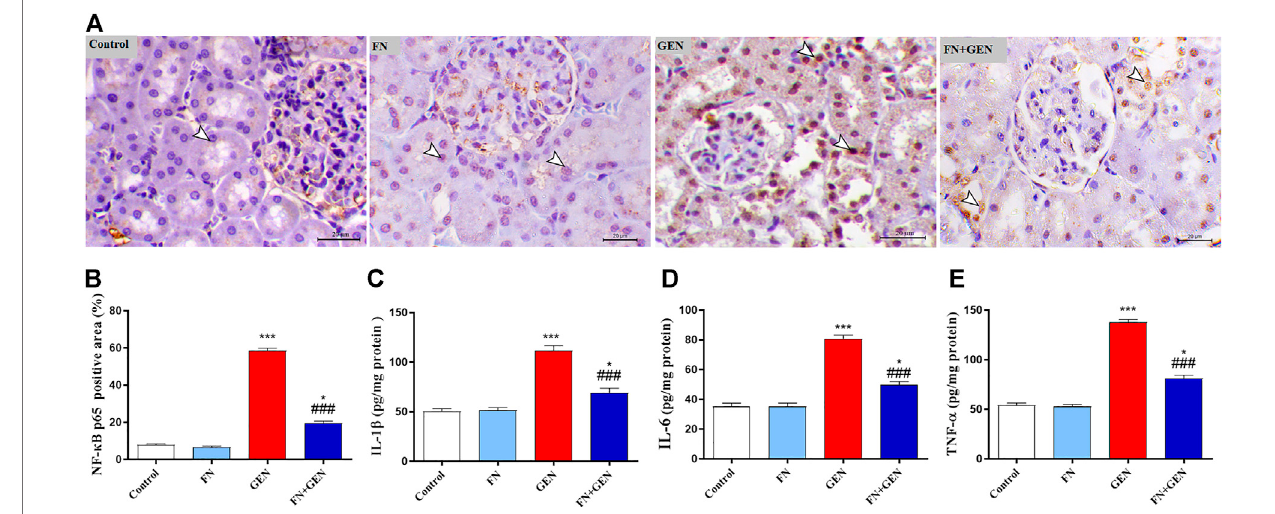
FIGURE 5 | FN attenuates renal in fl ammatory reaction in GEN-administered rats. (A) Photomicrographs of renal sections from control rats and FN-treated rats demonstrating a low level of NF- κ B p65 expression within the tubular epithelia (arrowheads), GEN-treated animals showing a high level of NF- κ B p65 expression (cytoplasmic and nuclear) within the tubular epithelia (arrowheads), and GEN-intoxicated rats pre-treated with FN demonstrating marked decrease of NF- κ B p65 expressionwithinthetubularepithelia(arrowheads)(IHC,X200,scalebar=20 µm). (B) ImageanalysisofNF- κ Bp65immunostaininginthekidneyofratsshowinga signi fi cant increase in GEN-administrated rats and a signi fi cant decrease in rats treated with FN. (C – E) FN attenuated renal (C) IL-1 β , (D) IL-6, and (E) TNF- α in GEN- intoxicatedrats.Resultsaremean±SEM( n =6). p indicates p < 0.05,and ppp indicates p < 0.001versuscontrolgroup,while###indicates p <